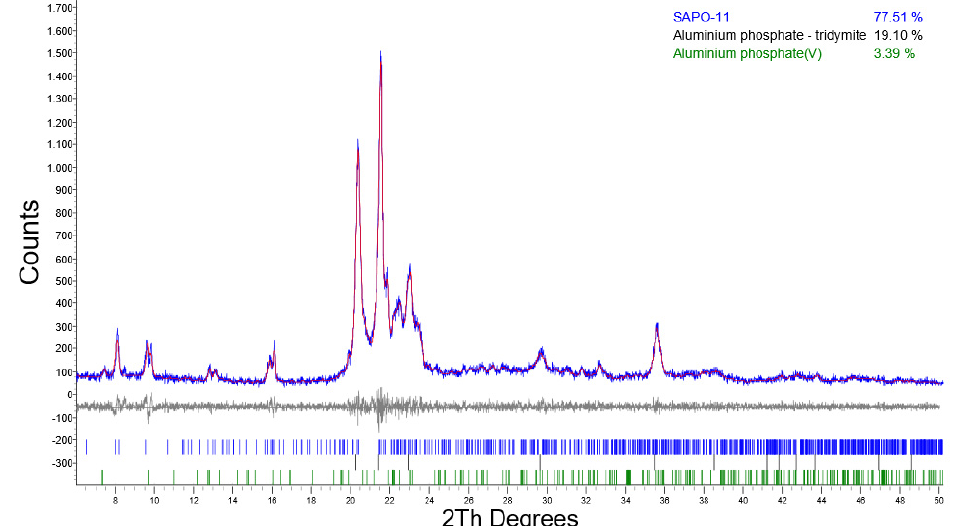
Figure A1 . Rietveld refinement plot for 24/SA: the vertical lines provide the positions of all possible Bragg reflections for aluminum phosphate tridymite phases, according to data presented in the literature [55]. Aluminum phosphate (V) (database_code_ICSD 88566) e SAPO-11 [56]. The values of the standard agreement indices are Rp—7.51, Rwp—10.02, Rexp—9.16, GofF—1.09.